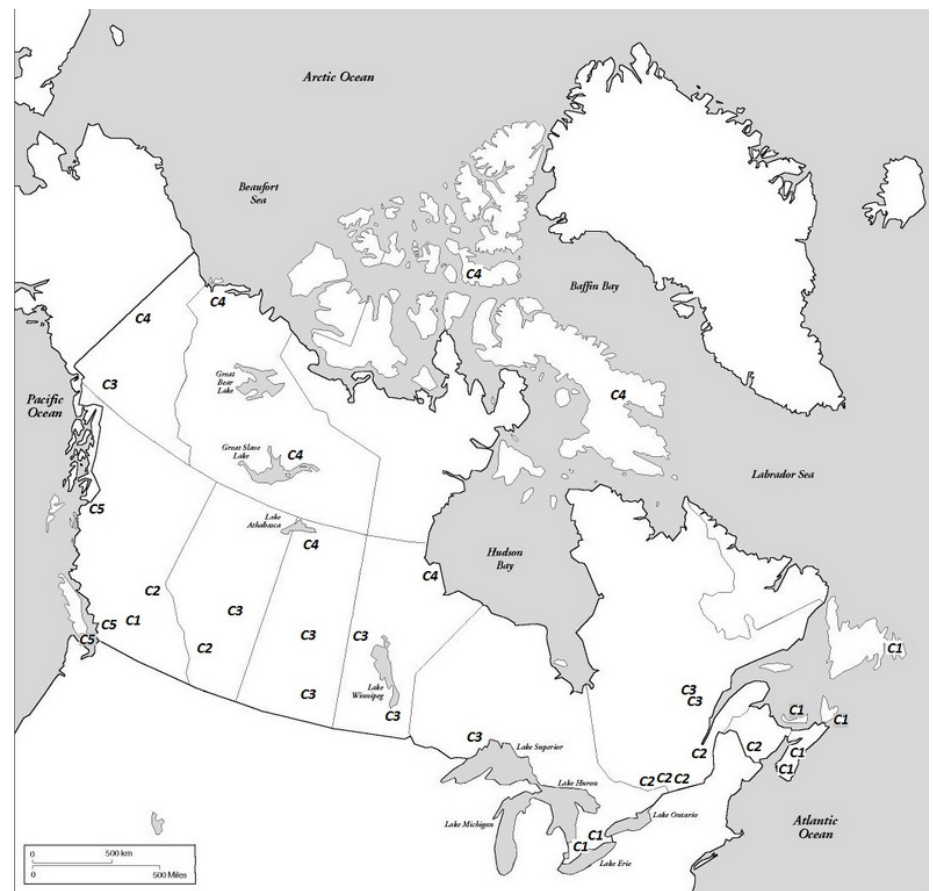
Figure A3. Map of Canada. The clusters are C1, C2, C3, C4, and C5 (see Table A1 for the list of cities in each cluster and Figure A2 for their temperatures). Adapted from http://goo.gl/Ok8CWv